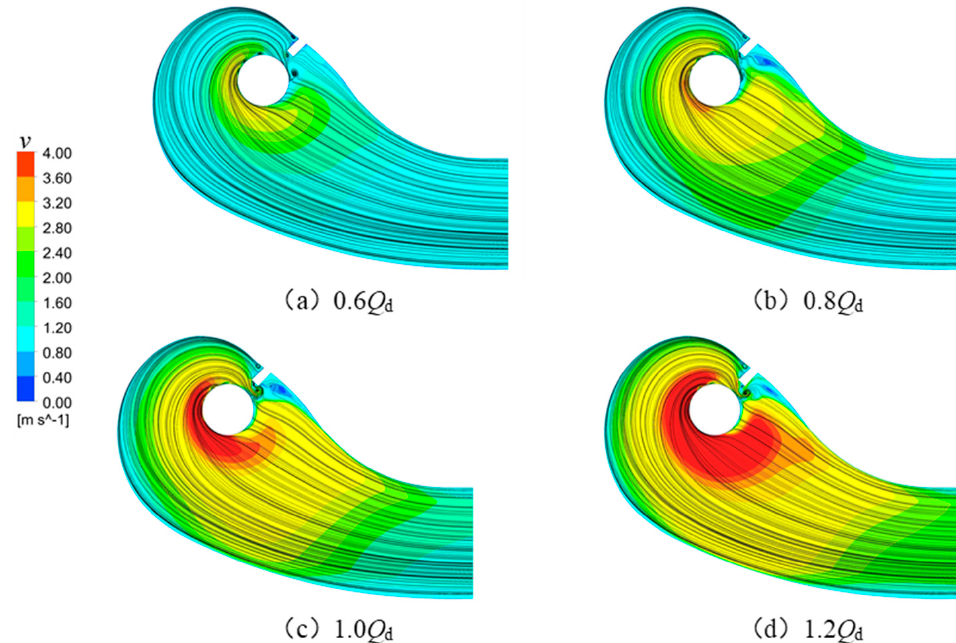
Figure 4. Velocity distribution in the suction under di ff erent fl ow rates.